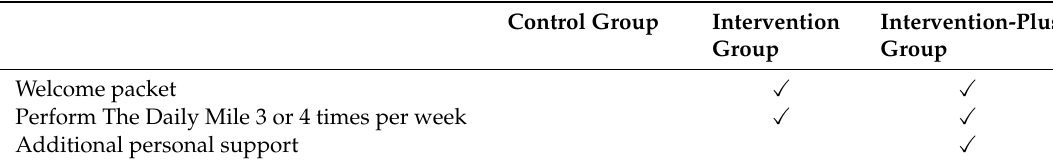
Table 1. Intervention components by experimental